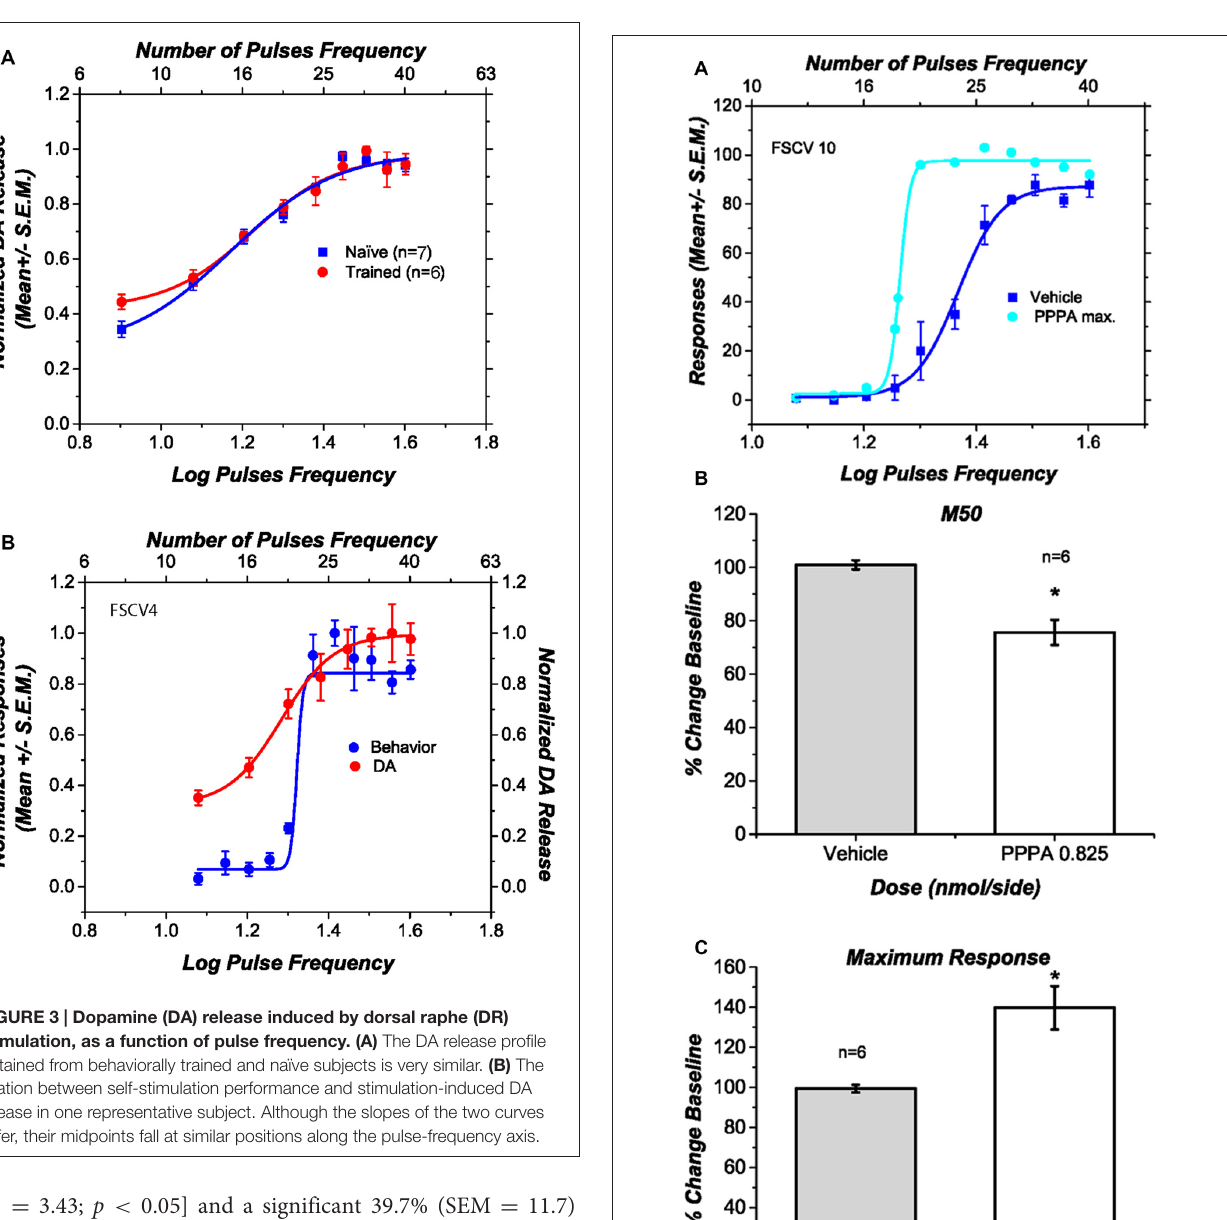
[ t ( 5 ) = 3.43; p < 0.05] and a significant 39.7% (SEM = 11.7)